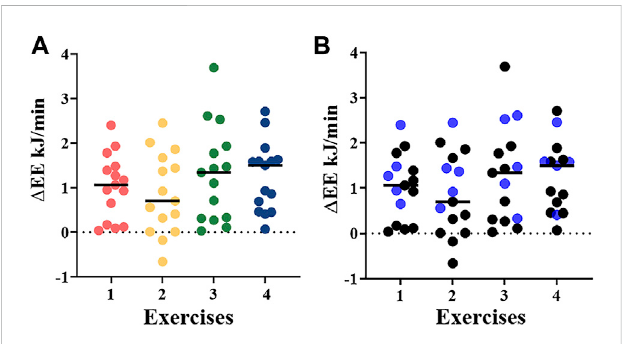
FIGURE 5 (A) Δ EE (KJ/min) derived from indirect calorimetry using the metabolic chamber during the four different exercises in 14 healthy controls. Exercise 1: cherry picking, exercise 2: little fl yer, exercise 3: boxing, exercise 4: hand biking; (B) Differentiation of Δ EE (kJ/min) during the four different exercises in 5 (blue dots) and 10 (black dots) healthy controls with and without overnight fasting, respectively.